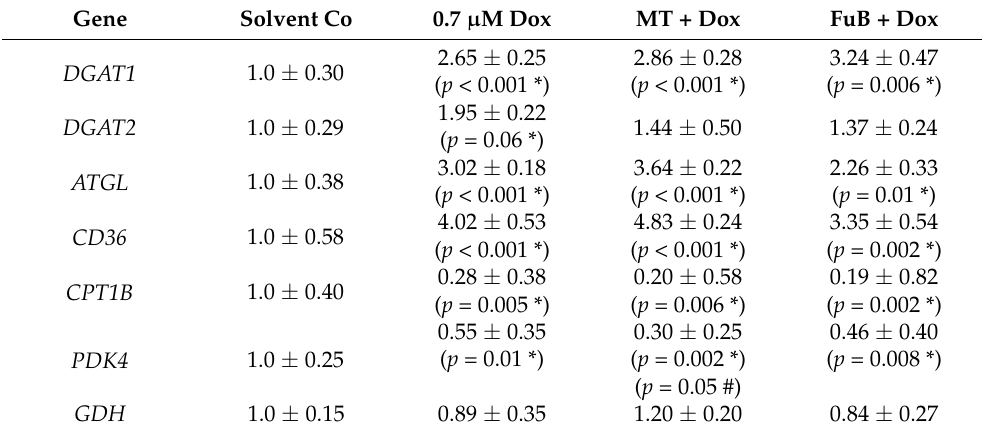
Table 3. Metabolism related mRNA